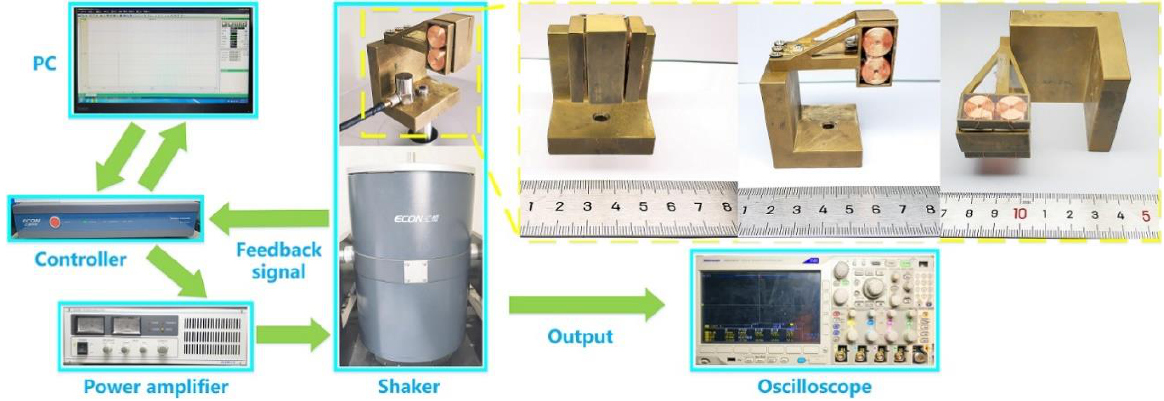
Figure 4. The prototype and experiment conditions.